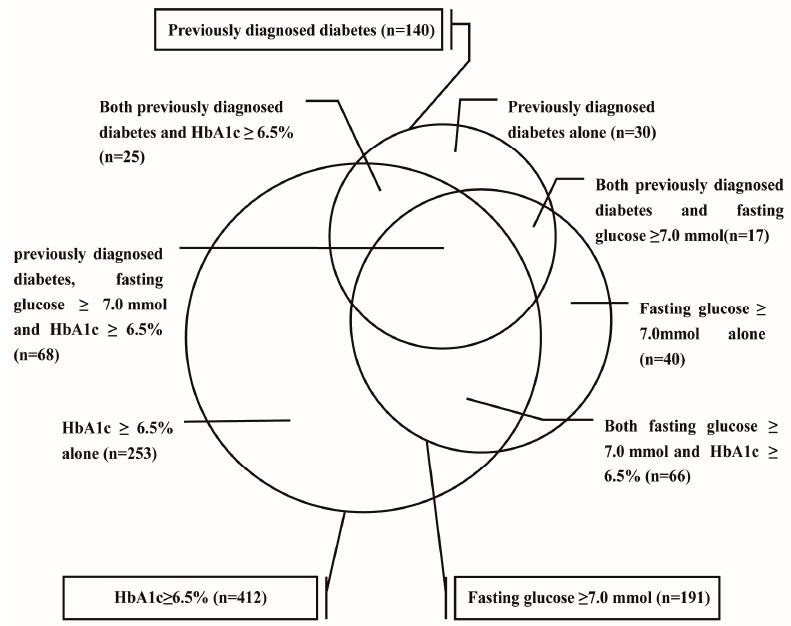
Figure 1. Overlap among participants with previously diagnosed diabetes, participants with HbA1c ≥ 6.5% (48 mmol/mol) and participants with fasting glucose ≥ 7.0 mmol. With increasing age, the prevalence of diabetes increased from 6.79% (18–39 years), 13.97% (40–59 years) to 29.21% (60–80 years) in females, and 7.51% (18–39 years), 16.73% (40–59 years), to 29.47% (60–80 years) in males. No significant differences were found for the prevalences of diabetes between males and females in the 18–39 ( p = 0.69), 40–59 ( p = 0.12) and 60–80 ( p = 0.94) years age groups. The same pattern was not found among those with prediabetes. In females, the prevalence of prediabetes in the 40–59 years age group was the highest (45.20%), followed by the 60–80 years